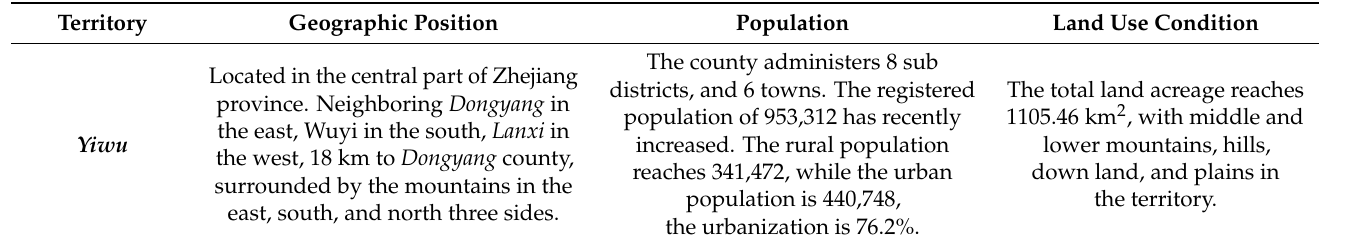
Table A1. Basic information on the research areas of Yiwu .